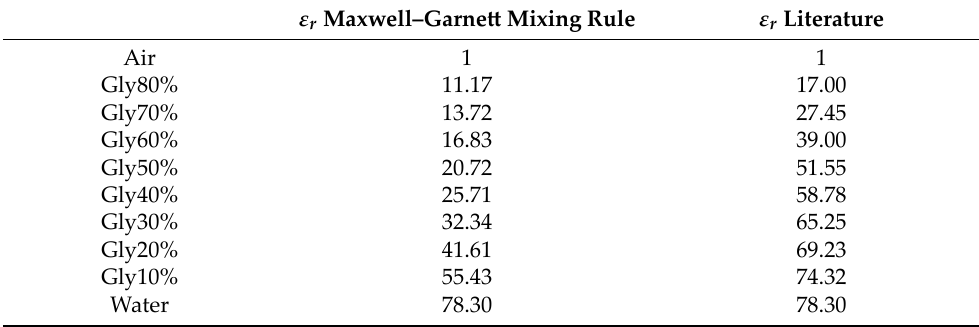
Table 1. List of glycerin solutions tested with their relative permittivity values at 20–21